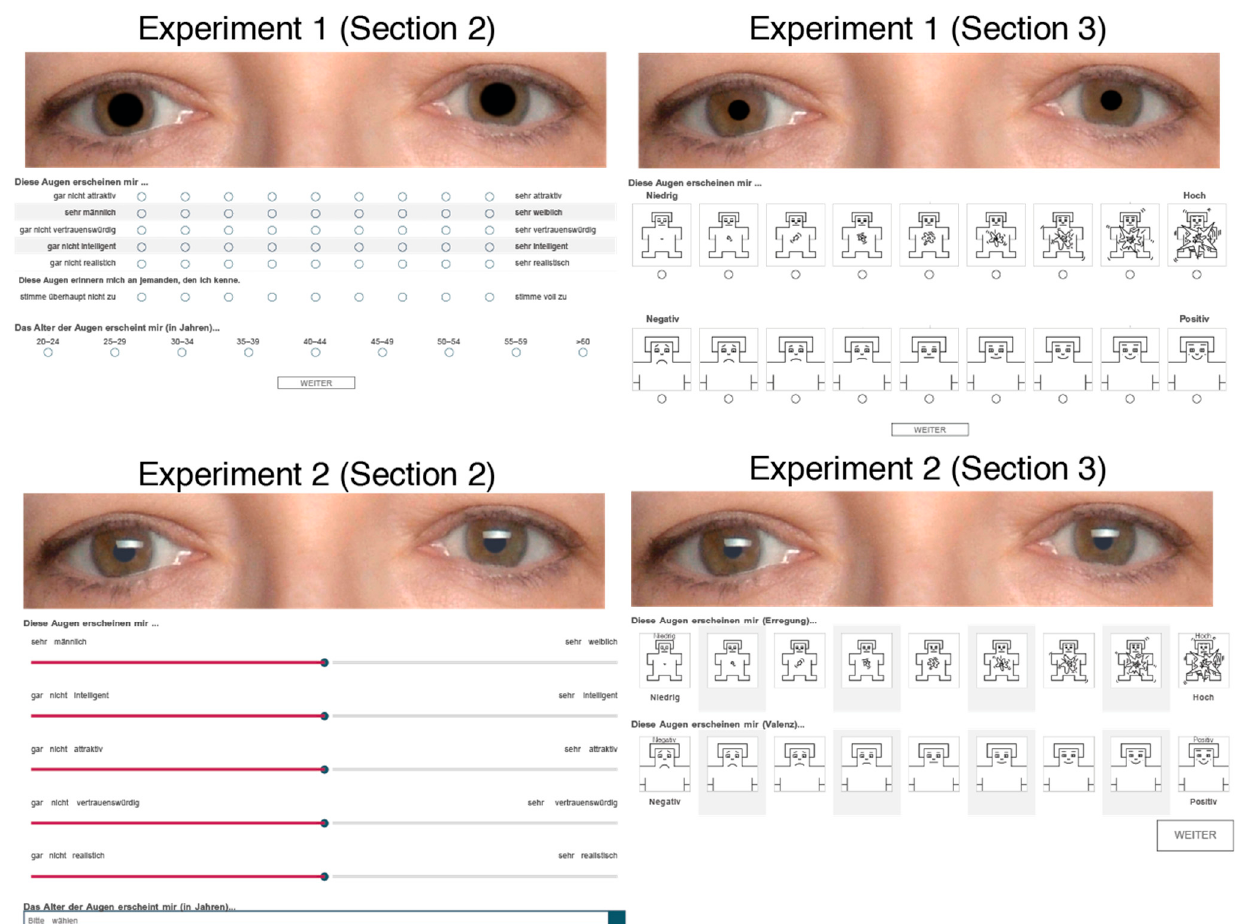
Figure 3. Sample screenshots of the survey layout in Sections 2 and 3 of the survey when the survey is not completed on a mobile device (i.e., mobile phone). In both experiments, the stimulus always appeared at the top of the screen. For illustration purposes, the eyes in Section 2 depict large pupils and those in Section 3 depict medium pupils.